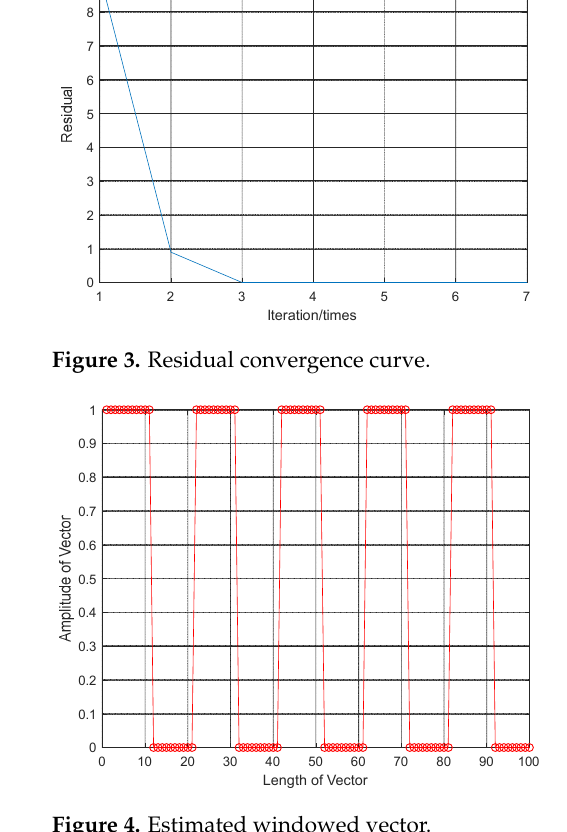
Figure 5. RMSE of slice width estimation.